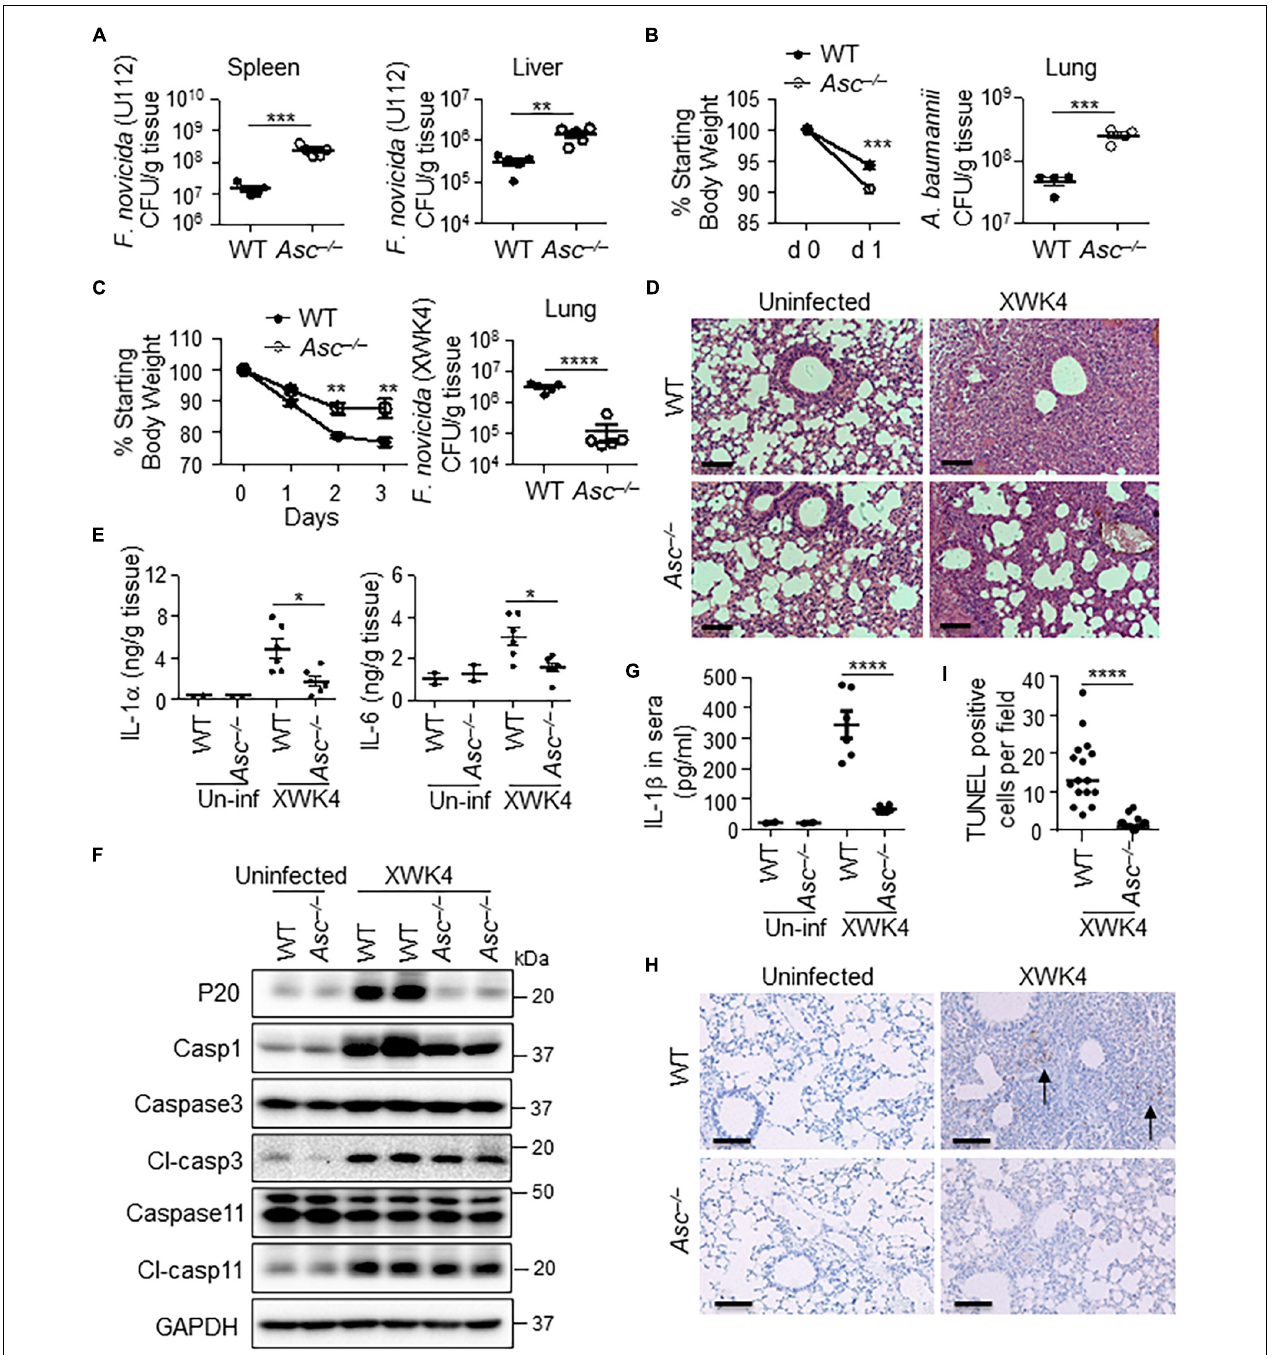
FIGURE 4 | ASC activation is detrimental for host defense against XWK4 infection. (A) WT and Asc − / − mice were infected subcutaneously with 1.5 × 10 5 CFU F. novicida (U112), and bacterial burden in the spleen and liver on day 2 after infection was measured. (B) WT and Asc − / − mice were infected intranasally with 5.0 × 10 8 CFU A. baumannii , and body weight loss after infection and bacterial burden in the lung on day 1 after infection were analyzed. (C) WT and Asc − / − mice were infected intranasally with 1.0 × 10 8 CFU F. novicida (XWK4), and body weight loss after infection and bacterial burden in the lung on day 3 after infection were analyzed. (D) H&E staining of lung sections from uninfected and XWK4-infected mice (C) . Scale bars: 100 µ m. (E) ELISA analysis of IL-1 α and IL-6 in the lungs from uninfected (Un-inf) and XWK4-infected mice (C) . (F) Immunoblot analysis of caspase-1, caspase-3, and caspase-11 in the lungs from uninfected and XWK4-infected mice (C) . (G) ELISA analysis of IL-1 β in sera from uninfected (Un-inf) and XWK4-infected mice (C) . (H) TUNEL staining of lung sections from uninfected (Un-inf) and XWK4-infected mice (C) . Arrow indicates the dead cells. Scale bars: 100 µ m. (I) Quantification analysis of TUNEL staining cells per field in the lung from XWK4-infected mice (H) . * p < 0.05; ** p < 0.01; *** p < 0.001; **** p < 0.0001 (one-way ANOVA with multiple comparisons and two-sided Student’s t -test without multiple comparisons correction). Data are representative of two independent experiments.